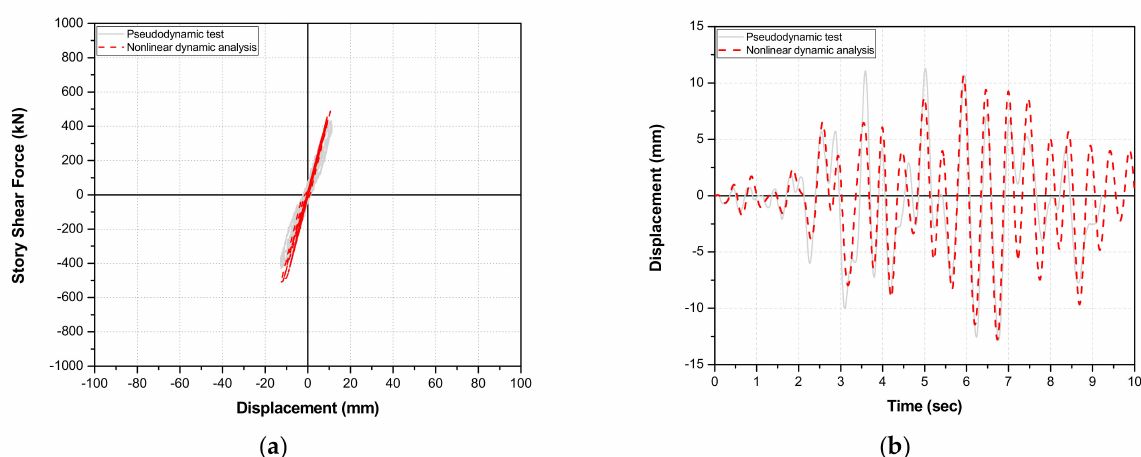
Figure 22. Comparison of non-linear dynamic analysis and pseudo-dynamic test results of test frame retrofitted with the